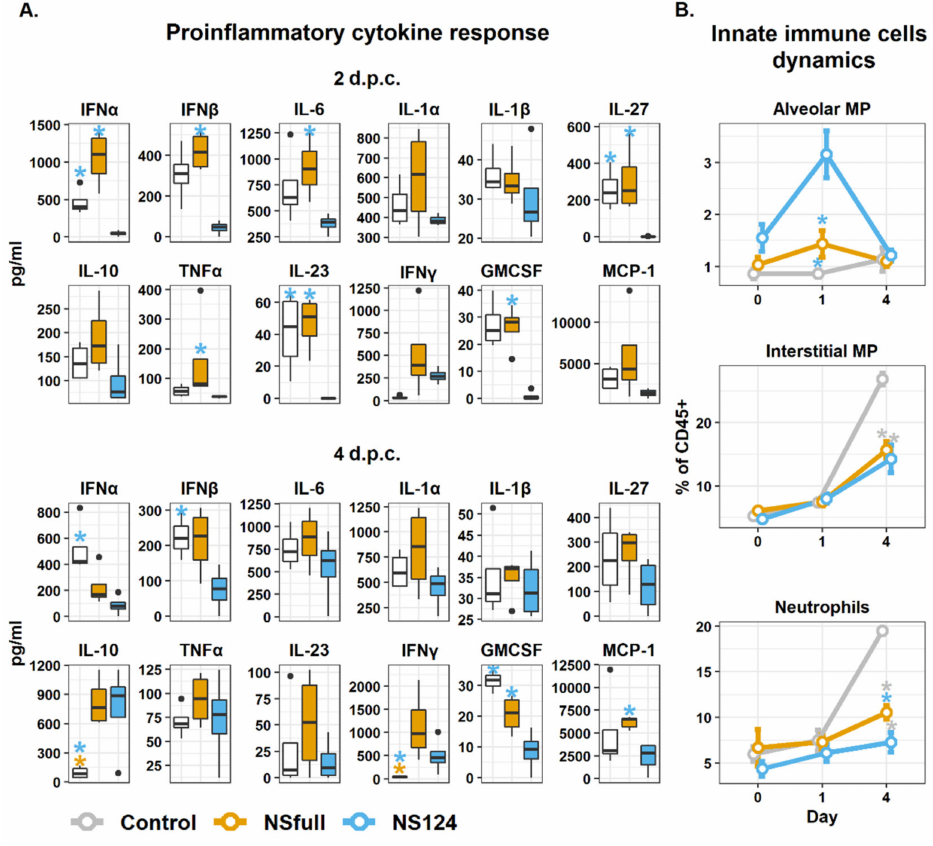
Figure 3. Proinflammatory cytokine response and innate immune cells’ dynamics in mice intranasally immunized with the A/PR8/NSfull and A/PR8/NS124 viruses after the heterologous challenge with A/Aichi/2/68. ( A ). Concentration of cytokines in lung tissue homogenates 2 and 4 days after the heterologous challenge (*: p < 0.05. Groups were compared using ANOVA followed by Tukey’s post-hoc test). ( B ). Percentage of alveolar macrophages, interstitial macrophages, and neutrophils in the lungs of immunized mice 0, 1, and 4 days after the heterologous challenge (mean ± SEM, n = 4, *: p < 0.05. Groups were compared using ANOVA followed by Tukey’s post-hoc